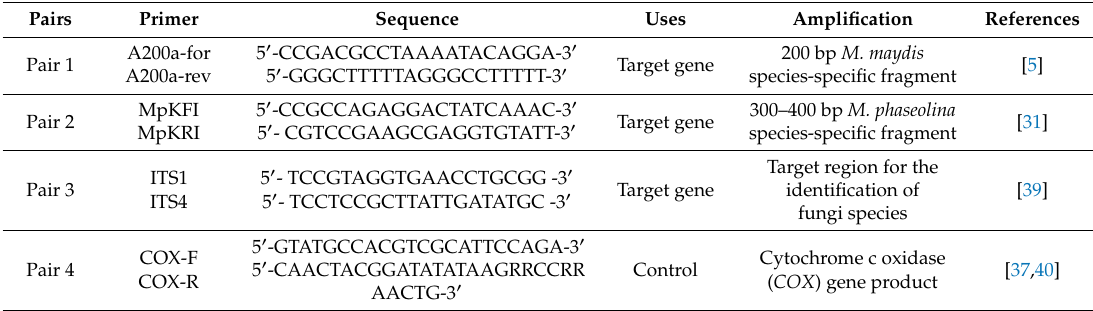
Table 3. Primers for Magnaporthiopsis maydis and Macrophomina phaseolina